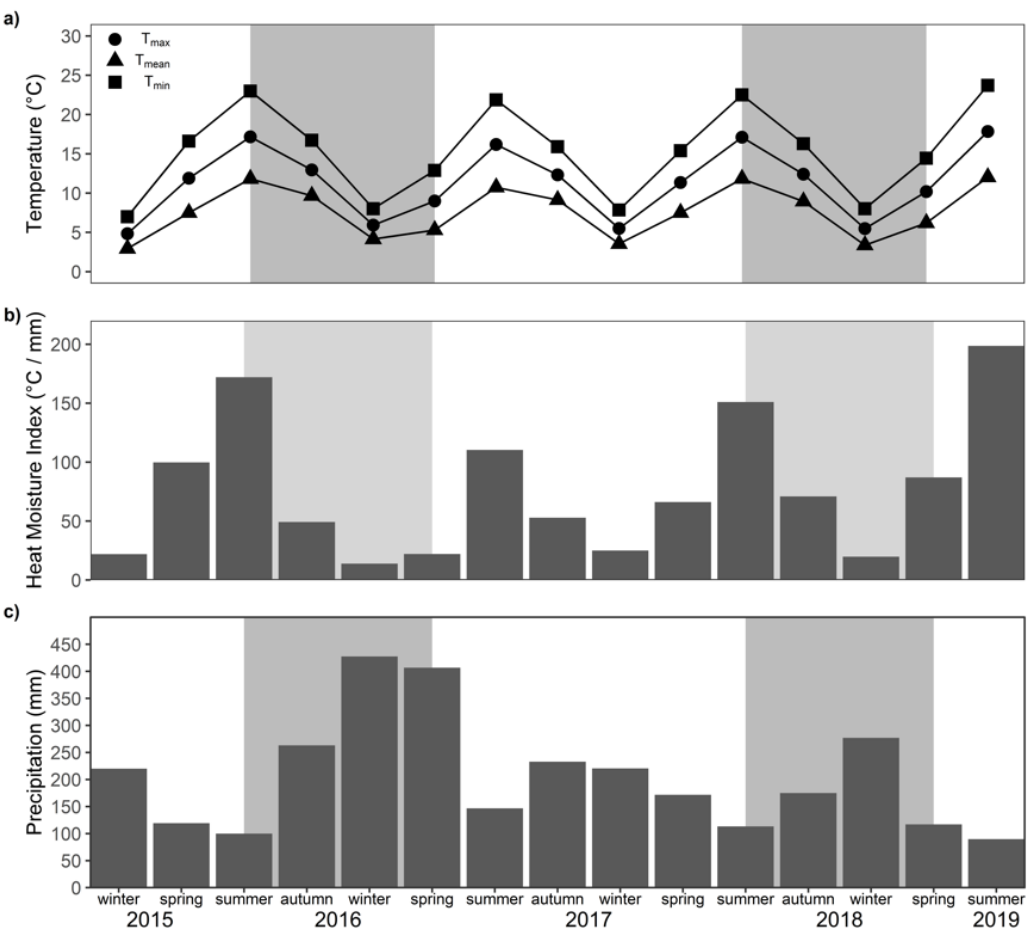
Figure 3. Seasonal changes in minimum (Tmin), mean (Tmean) and maximum (Tmax) temperature ( a ), seasonal heat moisture index ( b ) and precipitation ( c ) during the measurement period at the Wombat State Forest site.